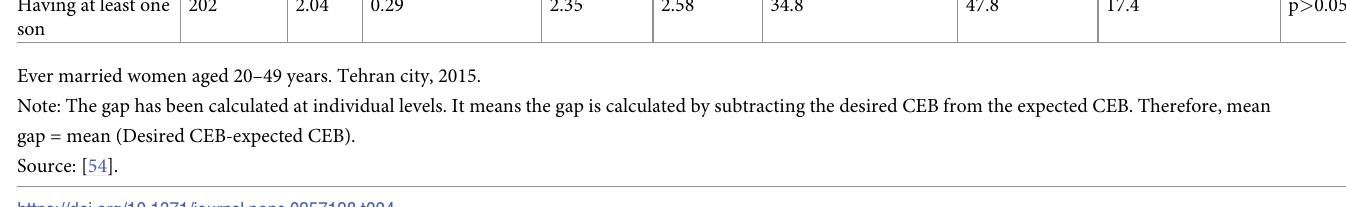
Having at least one